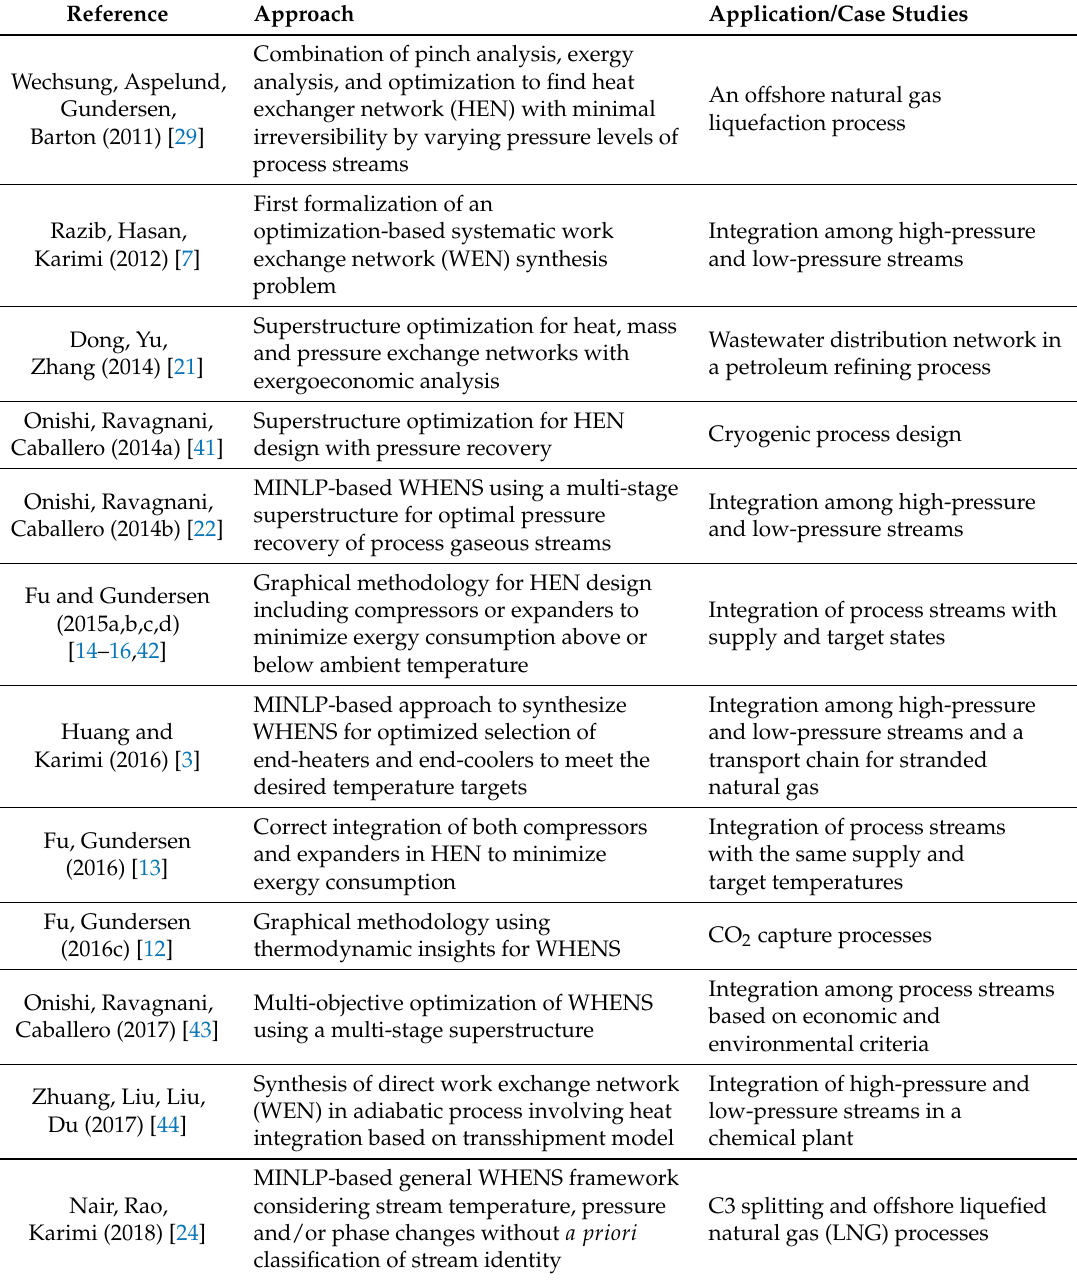
Table 1. An indicative list of recent contributions in WHENS